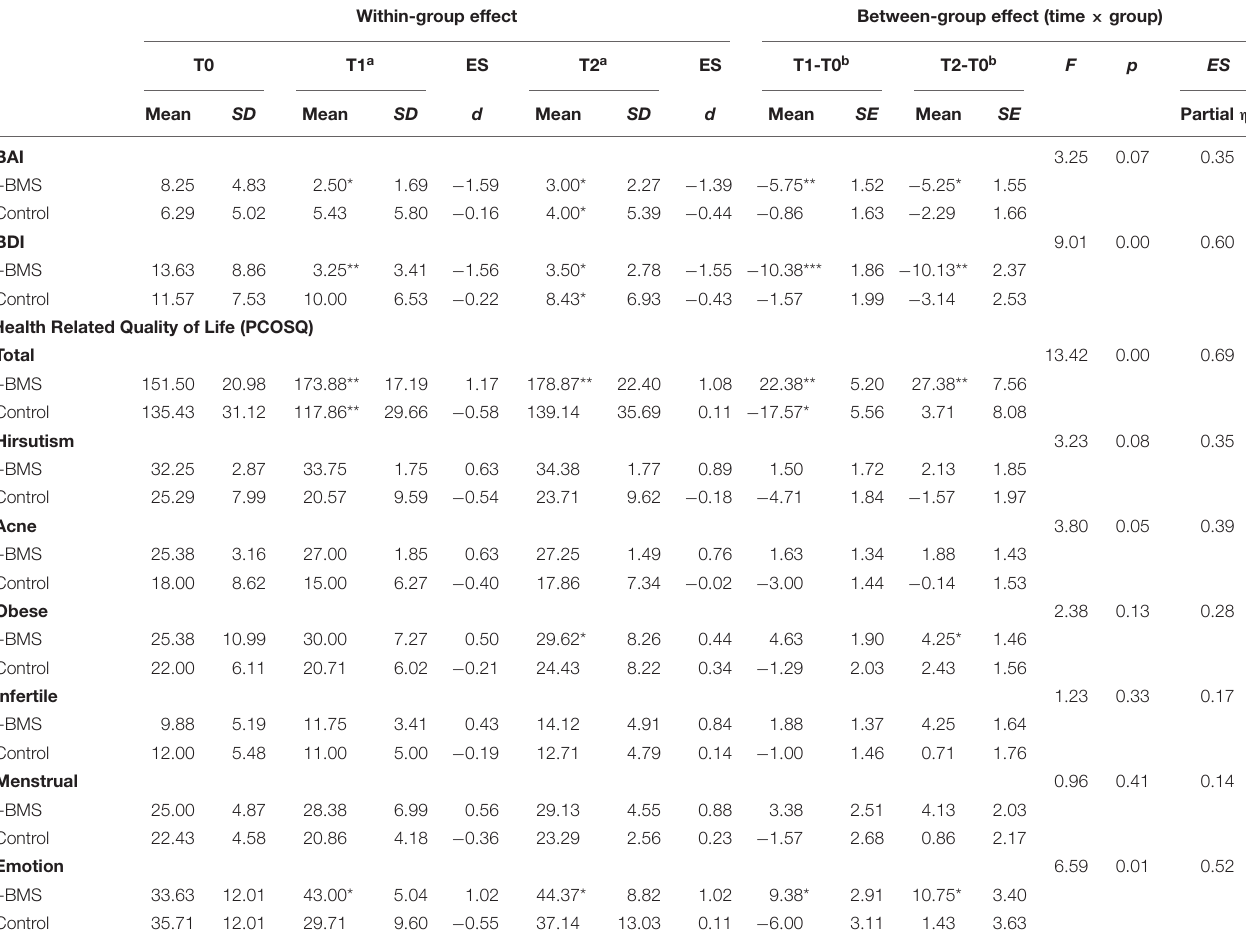
TABLE 5 | Anxiety, depression and health-related quality of life at study time points (Per protocol analysis, n = 15). Within-group effect Between-group effect (time ×